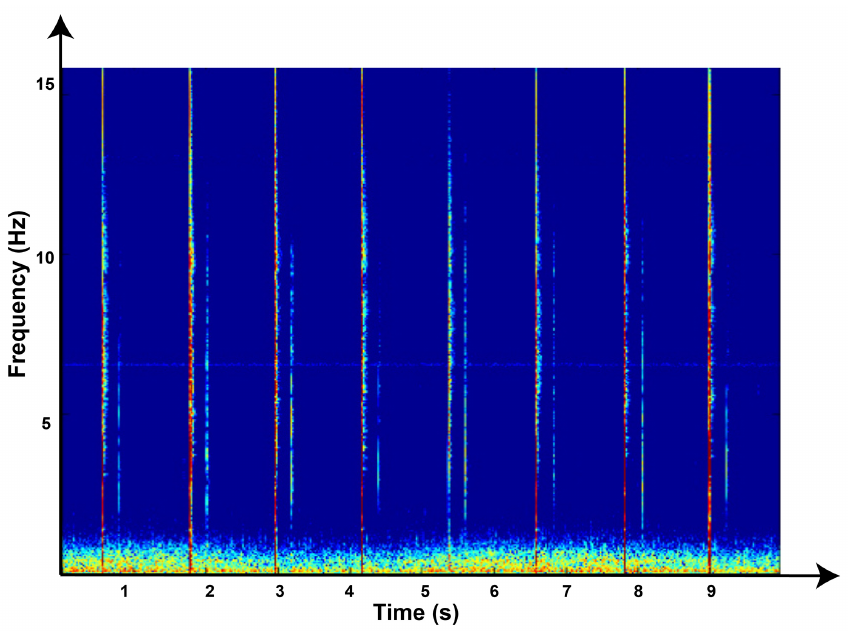
Figure 3. Spectrogram of a Sperm Whale click train.